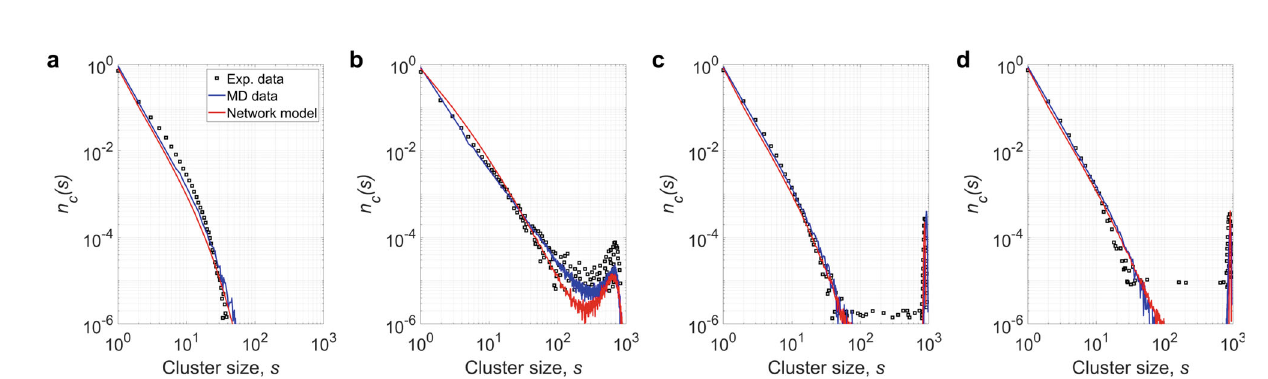
Fig. 5 | Comparison with experiments. Comparison of cluster size distributions from MD simulations and network model to experimental data of Bernabei et al. 10 for four conditions: a P r =1.13 and T r =1.04, b P r =2.26 and T r =1.04, c P r =6.79 and